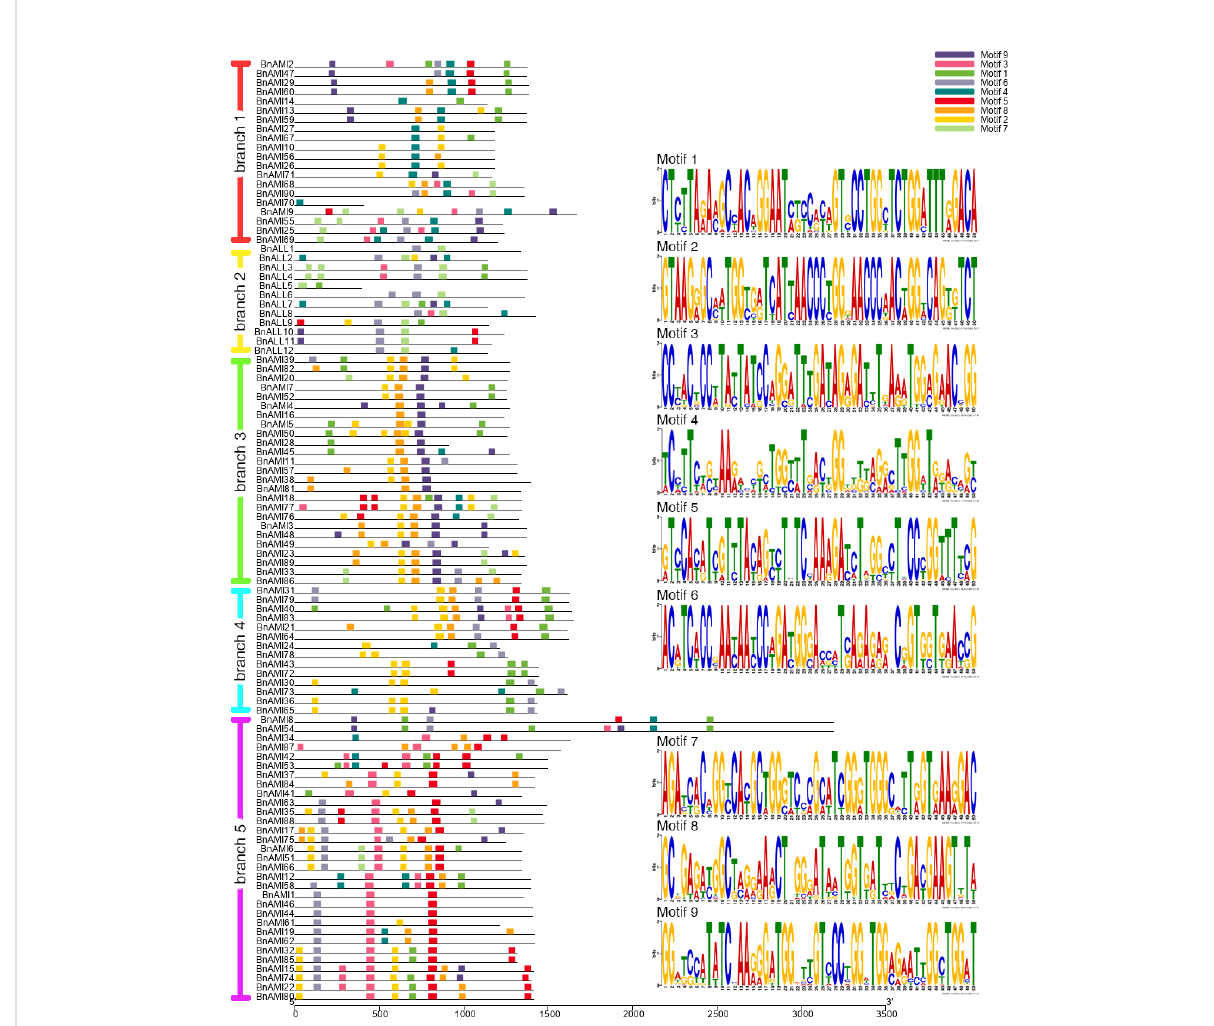
FIGURE 5 Motif patterns of different BnTAR branches and predicted consensus motifs in each BnTAR gene branch. Different motifs are shown in different colors. The lengths of the proteins and motifs can be estimated using the scale at the bottom. The motifs in Pfam of each branch are shown on the